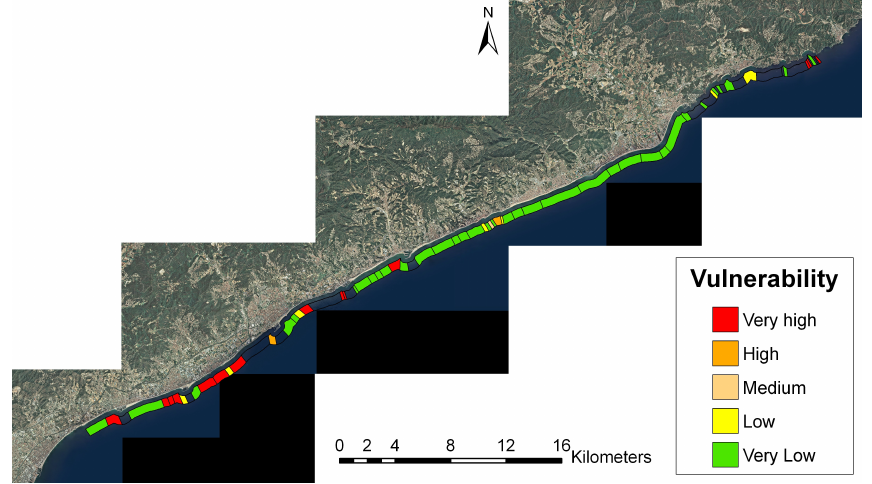
Fig. 10. Beach vulnerability to erosion associated to a return period of 50 years along the central part of the Catalan coast (Tordera